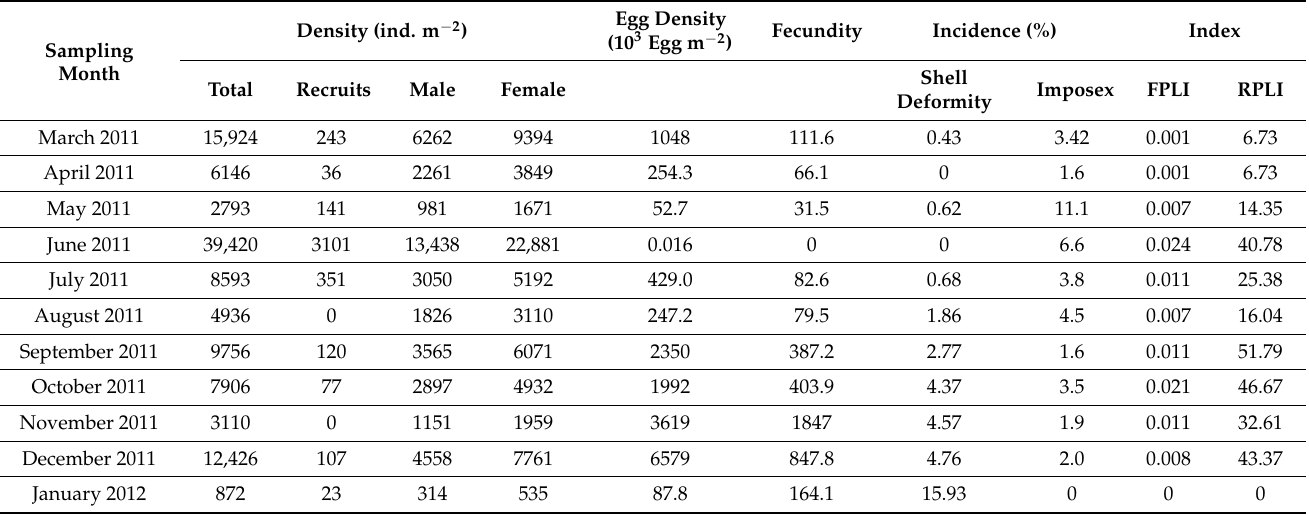
Table 3. Mean values of all the biological variables obtained for the Heleobia australis population from Guanabara Bay (Rio de Janeiro,